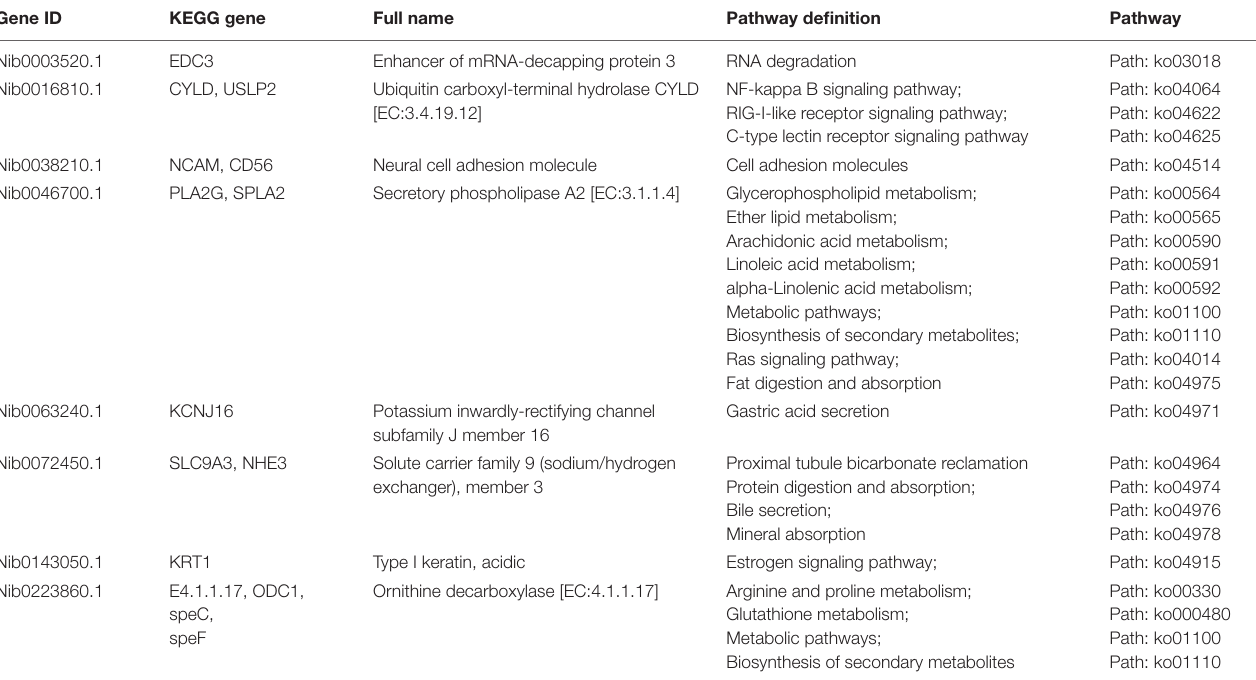
TABLE 5 | Twenty-two co-expressed